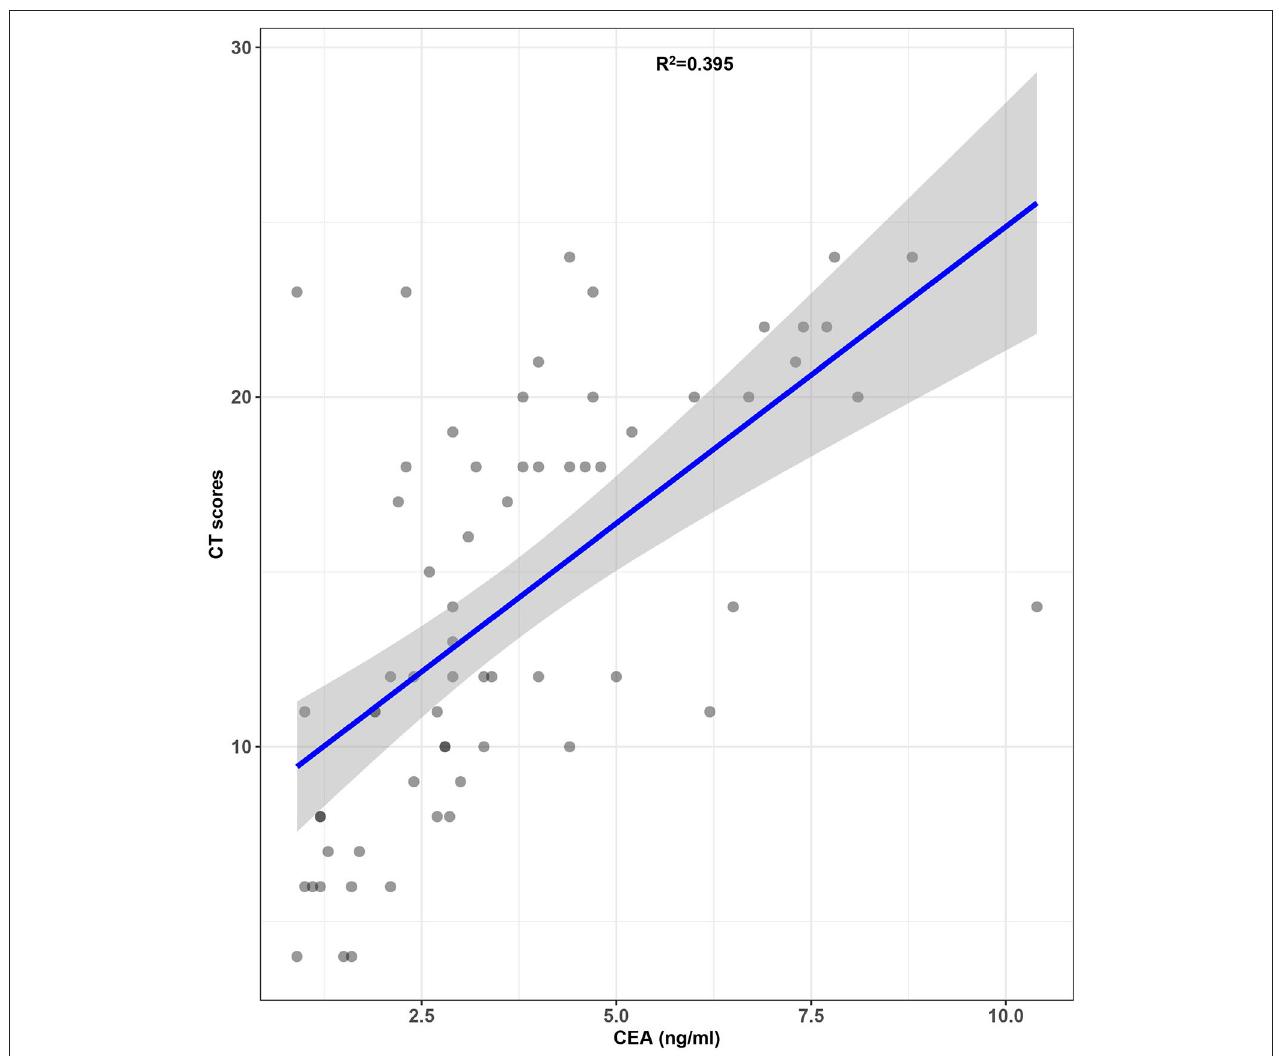
FIGURE 4 | Correlation of CEA levels with CT scores in discharged COVID-19 patients (the gray area on the figure means 95% confidence intervals).